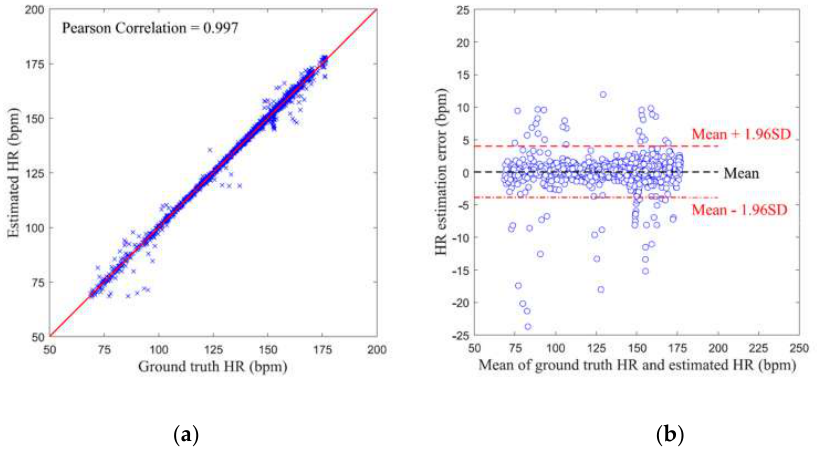
Figure 7. The evaluation of the difference between heart rate (HR) estimation results and the reference HR values: ( a ) Pearson correlation plot for HR AAE results; ( b ) Bland–Altman plot for HR AAE results.